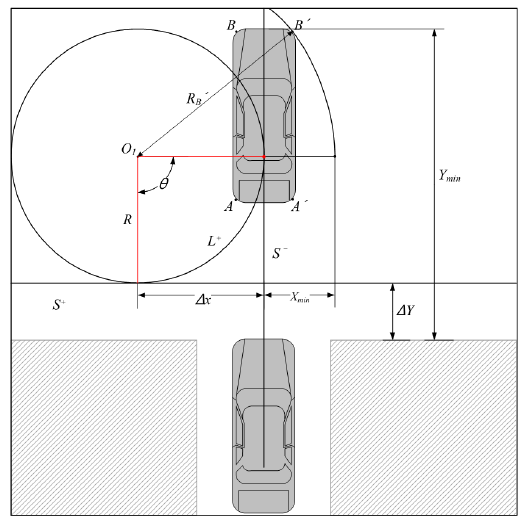
Figure 4. (𝑆 (cid:2878) 𝐿 (cid:2878) 𝑆 (cid:2879) ) perpendicular parking: 𝜃 = 90°